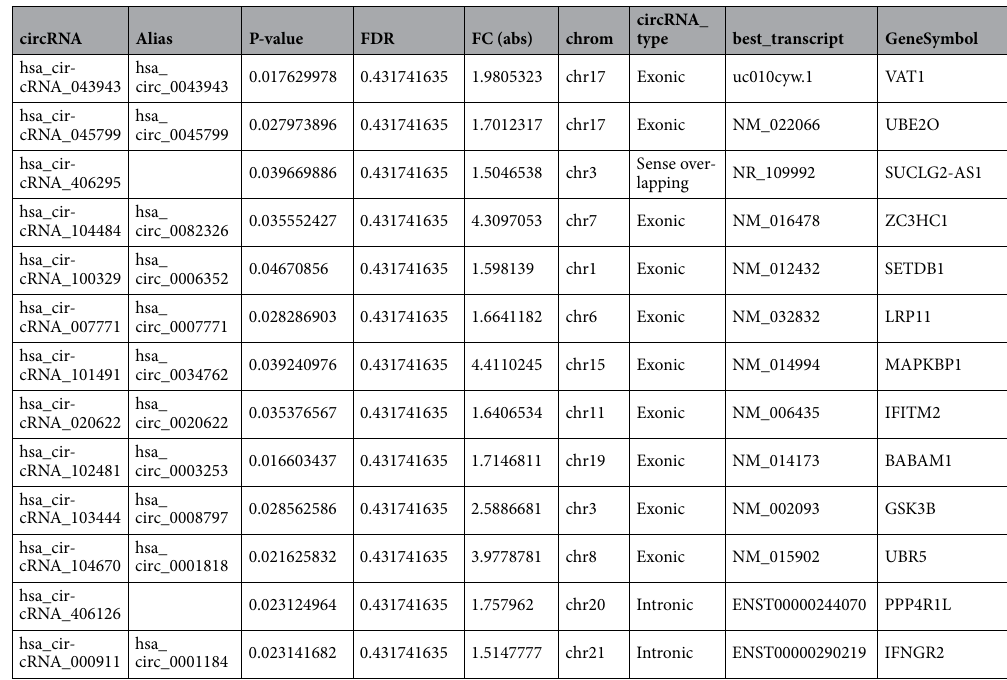
Table 3. Differentially up-regulated circRNAs in serum exosomes of patients with sepsis. FDR: false discover rate; FC: fold